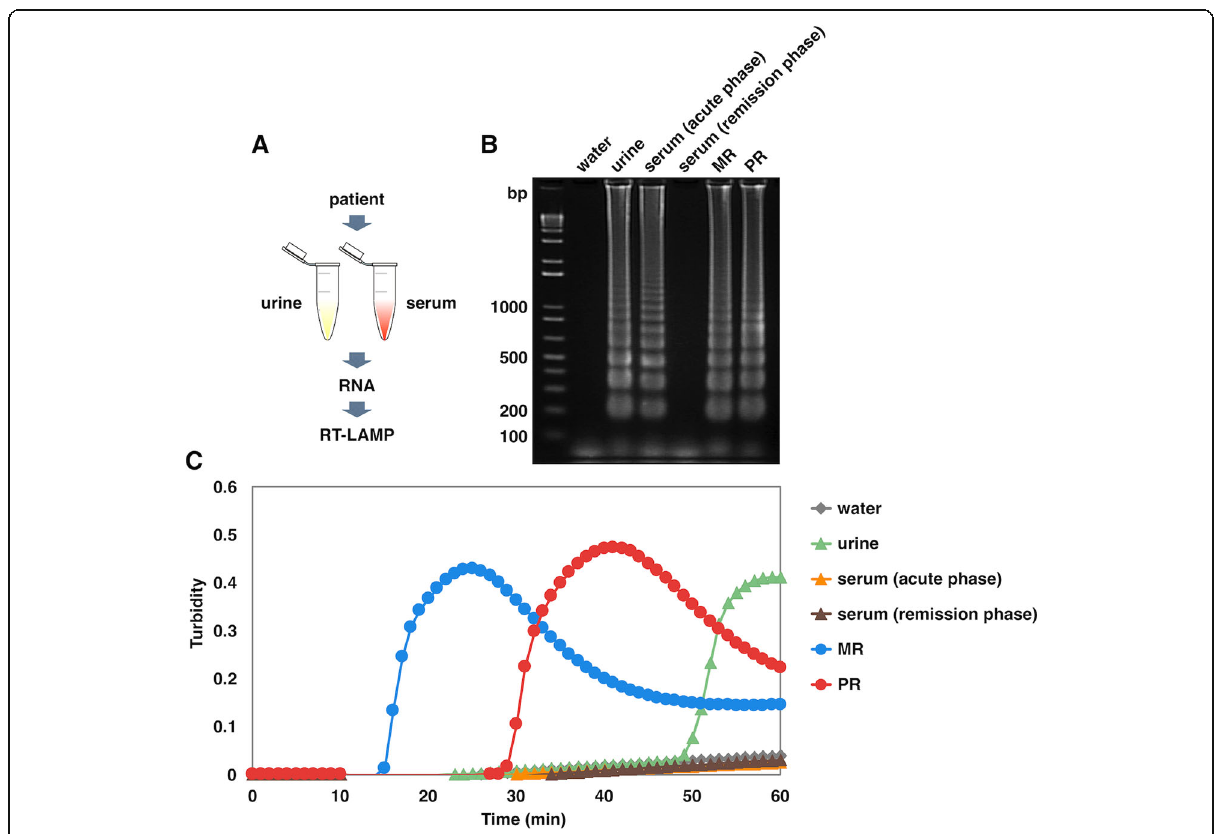
Fig. 3 RT-LAMP-based detection of ZIKV from a Zika fever patient. a Scheme of preparing patient samples for RT-LAMP. RNA extracted from each patient sample (urine, serum (acute phase), and serum (remission phase)) was provided for ZIKV detection in the RT-LAMP reaction for 60 min at 62 °C. Water served as a negative control in the RT-LAMP reaction. RNA from ZIKV MR and PR served as positive controls. b Amplified products were electrophoresed on a 2% agarose gel. Numbers on the left indicate migration of the molecular weight marker (bp). c Amplification of the target sequence contained in patient samples was monitored using a real-time turbidimeter (turbidity at 650